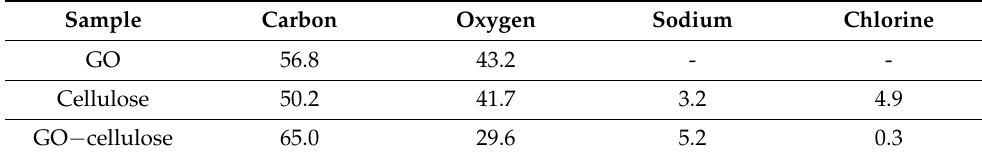
Figure 4. EDS spectra of GO (a),extracted cellulose (b), and GO–cellulose composite (c). Table 1. The element compositions in GO, extracted cellulose, and GO−cellulose composite.